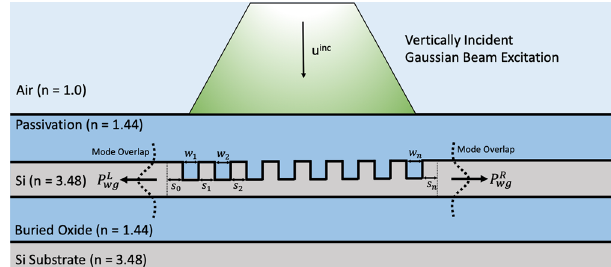
Fig. 1 Diagram of the proposed grating coupler wavelength demultiplexer geometry (GCWD). The individual tooth widths and spacings (shown to be uniform in the fi gure, for simplicity) are parametrized by the variables w i and s i respectively. These variables are selected by the inverse design algorithm to optimize the demultiplexing objective function. The input excitation is modeled as a radiative-type Gaussian beam which closely matches the free-space fi eld emanating from an optical fi ber. The quantities n , u inc , P L , and P L denote the refractive indices, the incident beam wg wg excitation, and the power coupled into the left and right silicon waveguides, respectively.